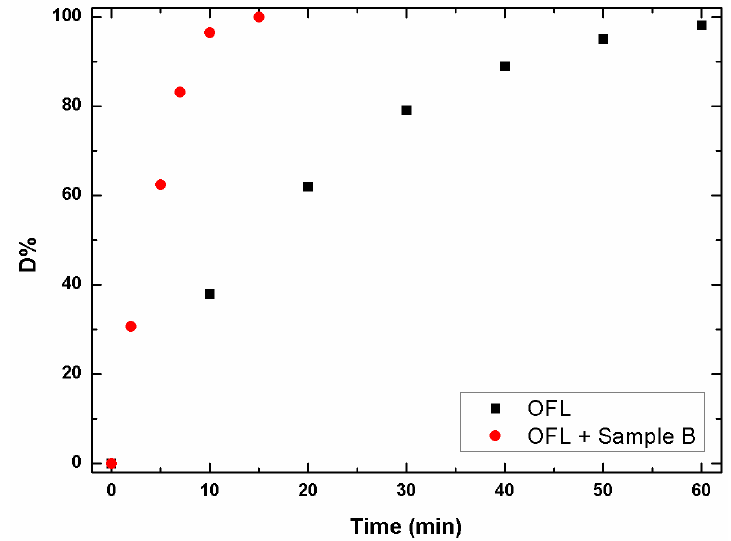
Figure 5. Photolytic ( (cid:4) ) and photocatalytic ( • ) degradation profiles of OFL under simulated solar light. The experimental points (Table S2) are averaged over three replicates (RSDs < 5%, n = 3) (Color figure online).